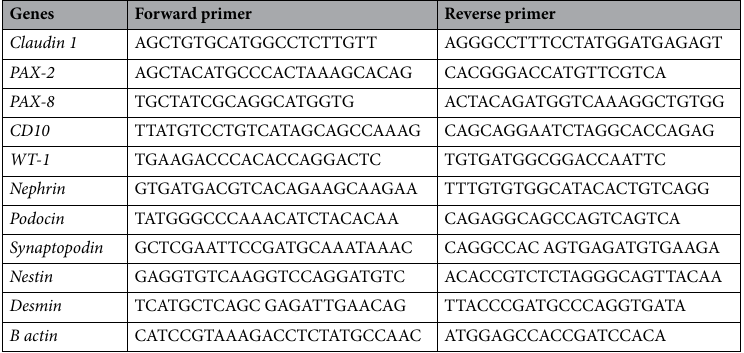
Electron microscopy.